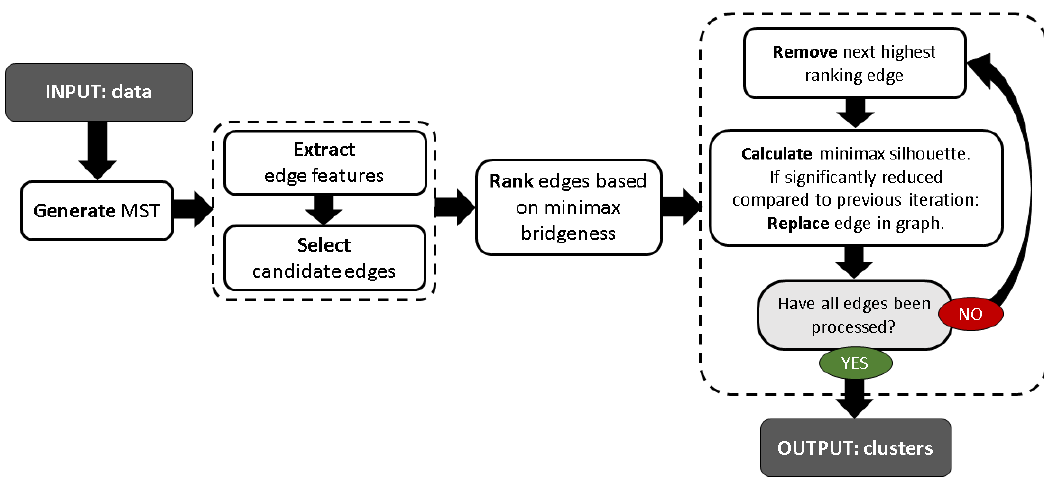
Figure 3. Flowchart of the proposed Minimax Bridgeness-based